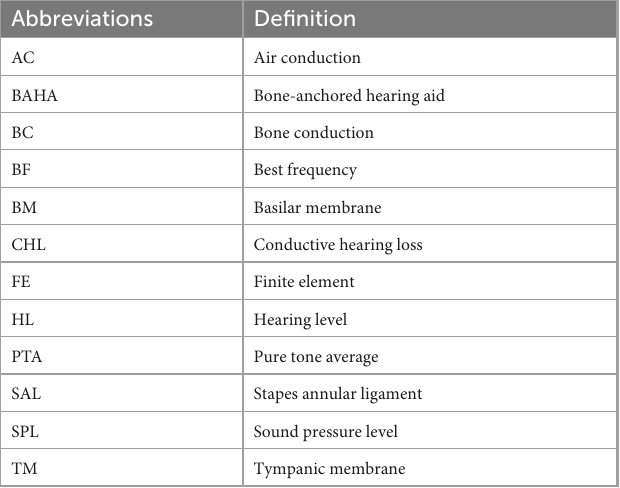
TABLE 1 Summary of abbreviations for the present